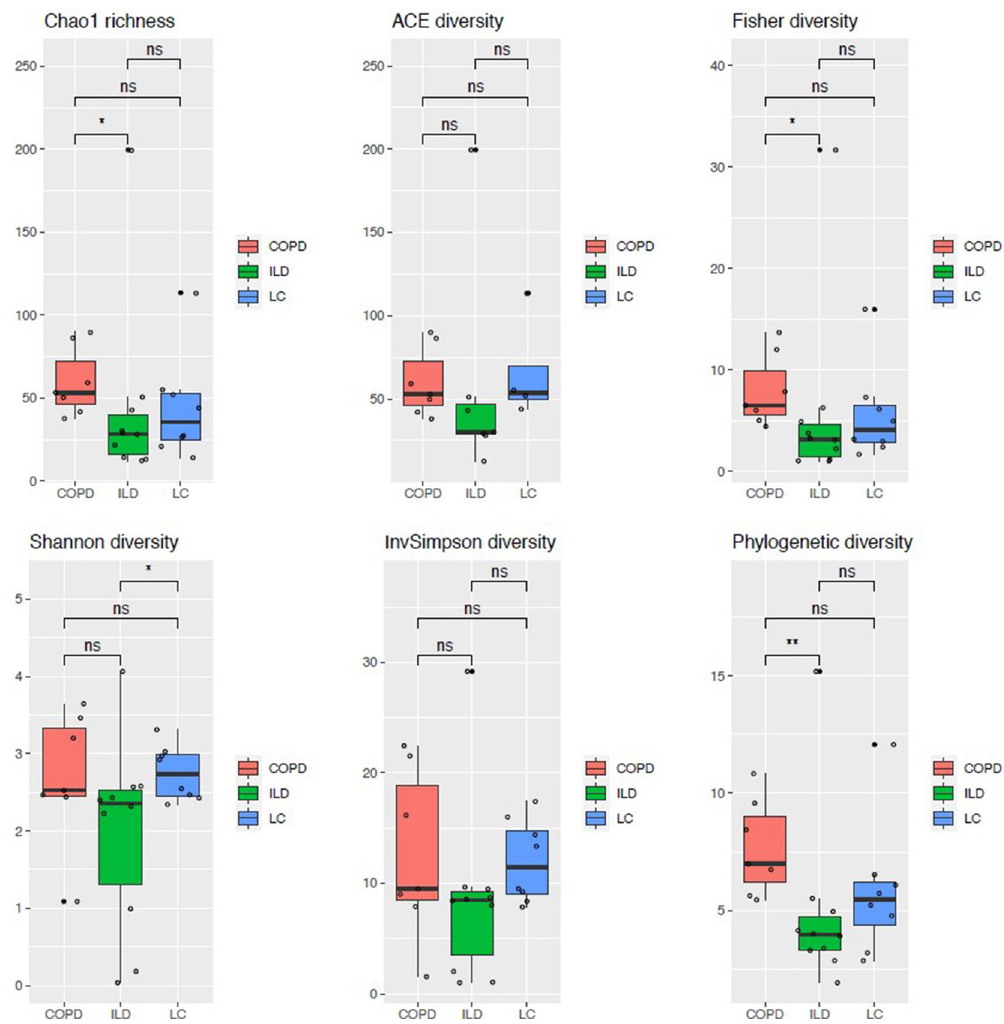
Figure 2. Alpha diversity of the CLD comorbidity-controlled dataset COPD (N = 7), ILD (N = 10) and LC* (N = 8) groups. Displayed estimates: Chao richness and Shannon, ACE, Inversed Simpson, Fisher and Phylogenetic (Faith’s) diversity indices. Significant p- values for pairwise group comparisons are indicated as (*) for p < 0.05 and (**) for p < 0.01. ns: